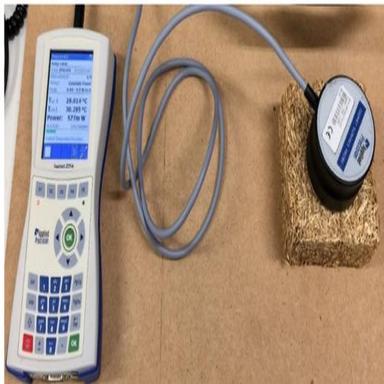
Thermal conductivity setup using ISOMET.